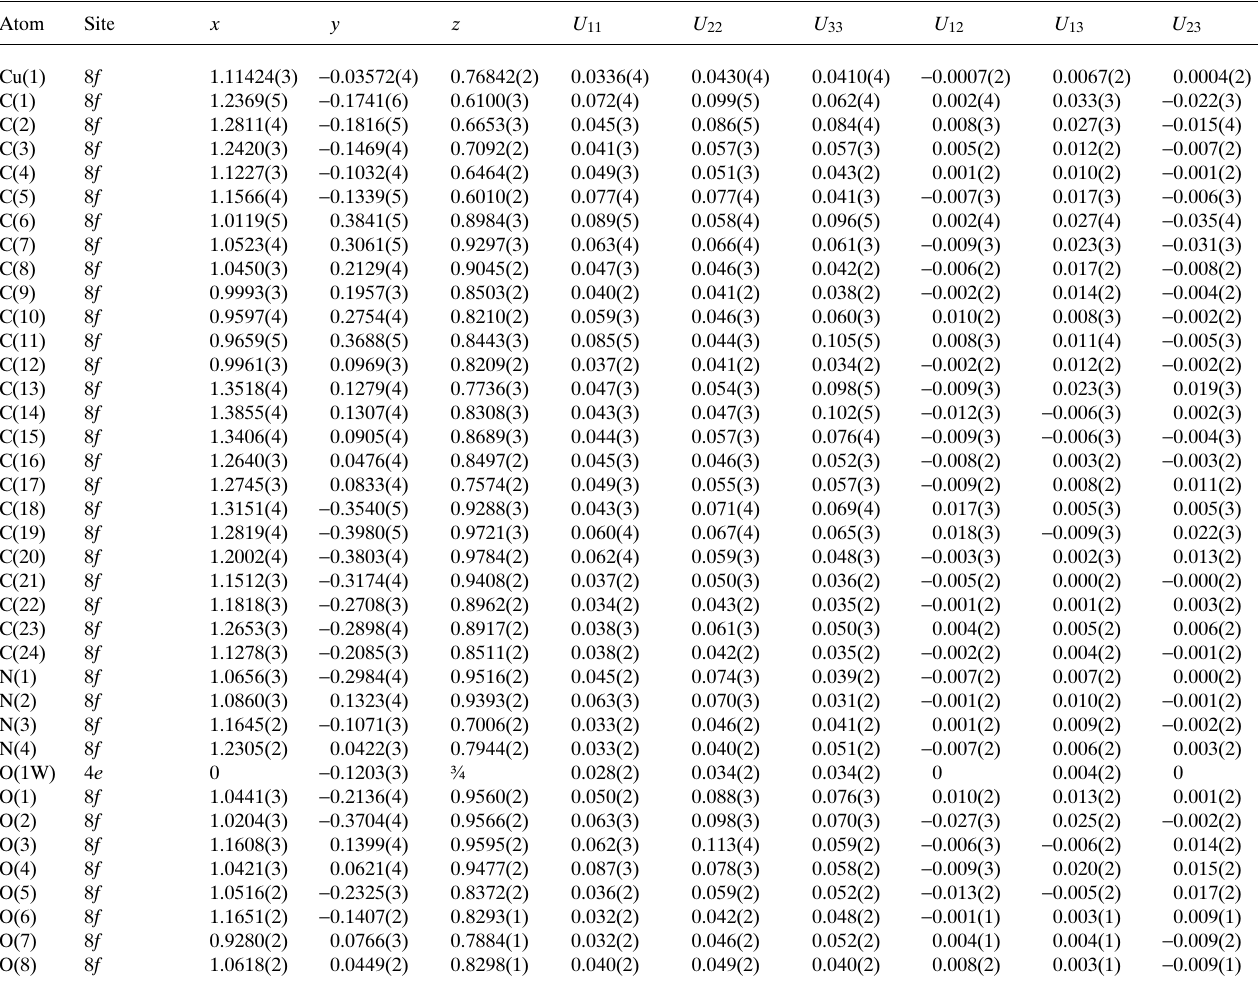
Table 3. Atomic coordinates and displacement parameters (in Å 2 )